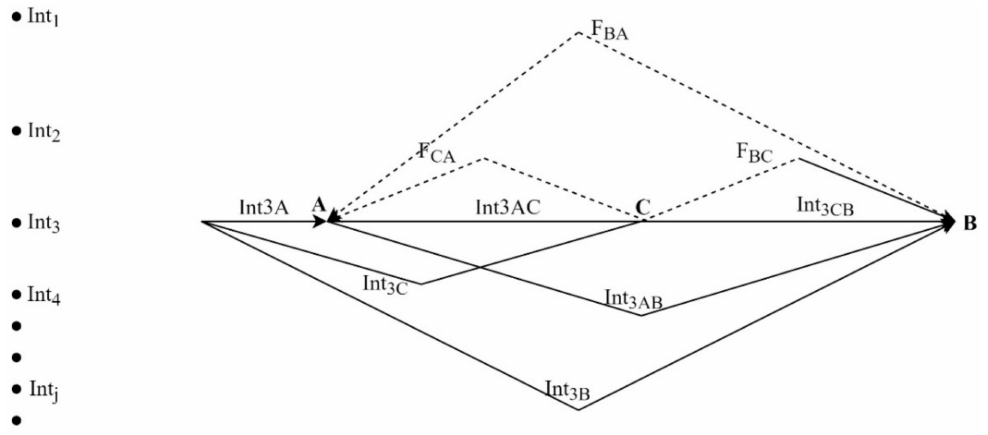
Figure 1. The Westley–McLean integral communication